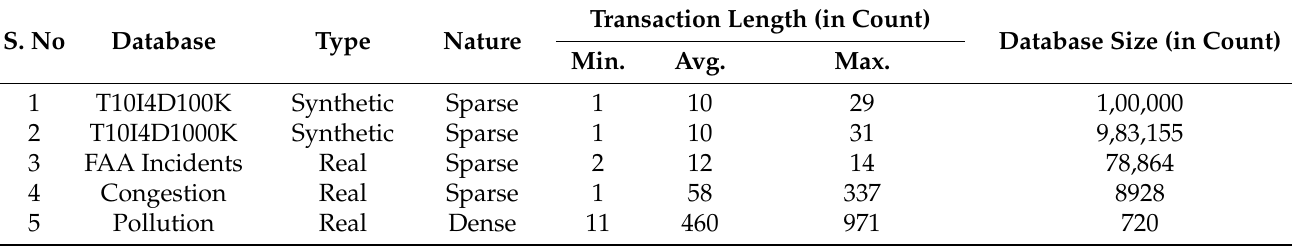
Table 4. The complete statistics of the databases that were used in our experiments: the minimum, average, and maximum transactions of the databases are represented by min., avg., and max., respectively.